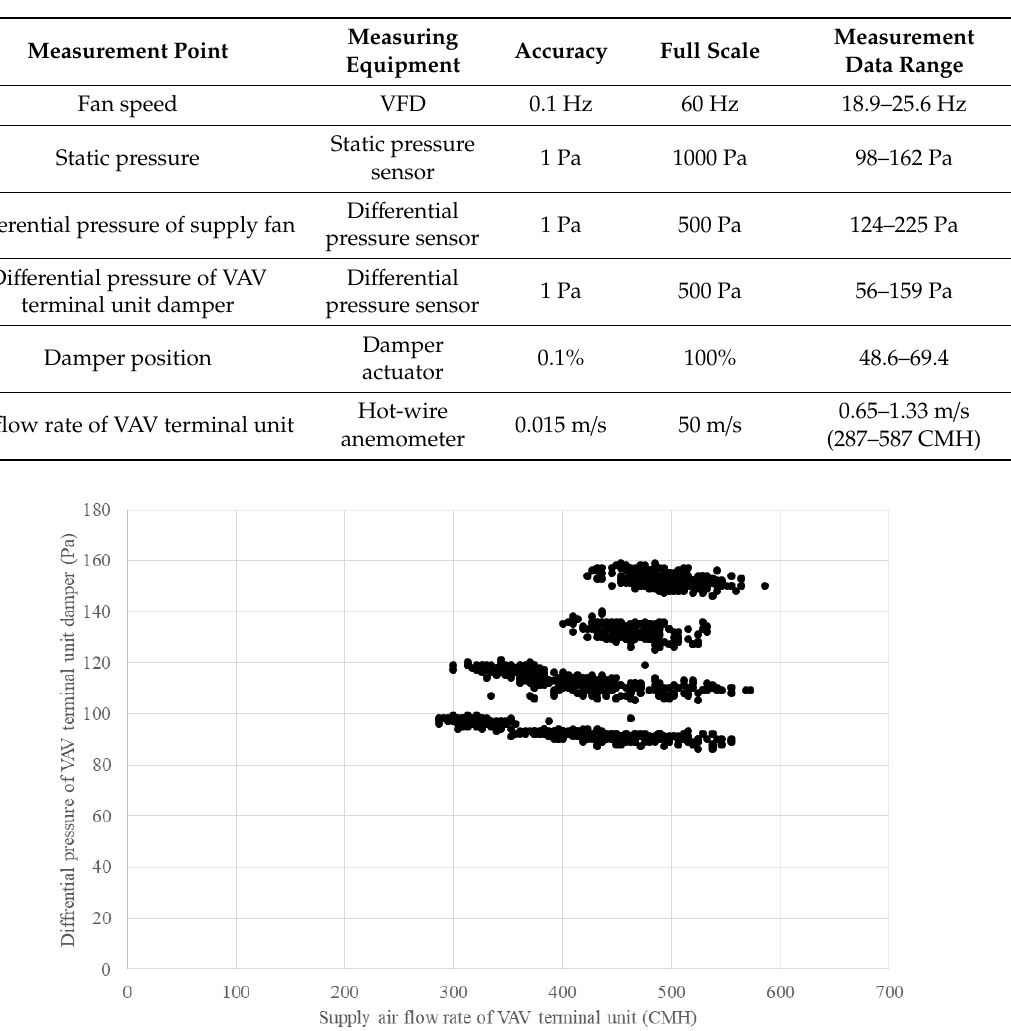
Table 2. Summary of measured data and equipment.